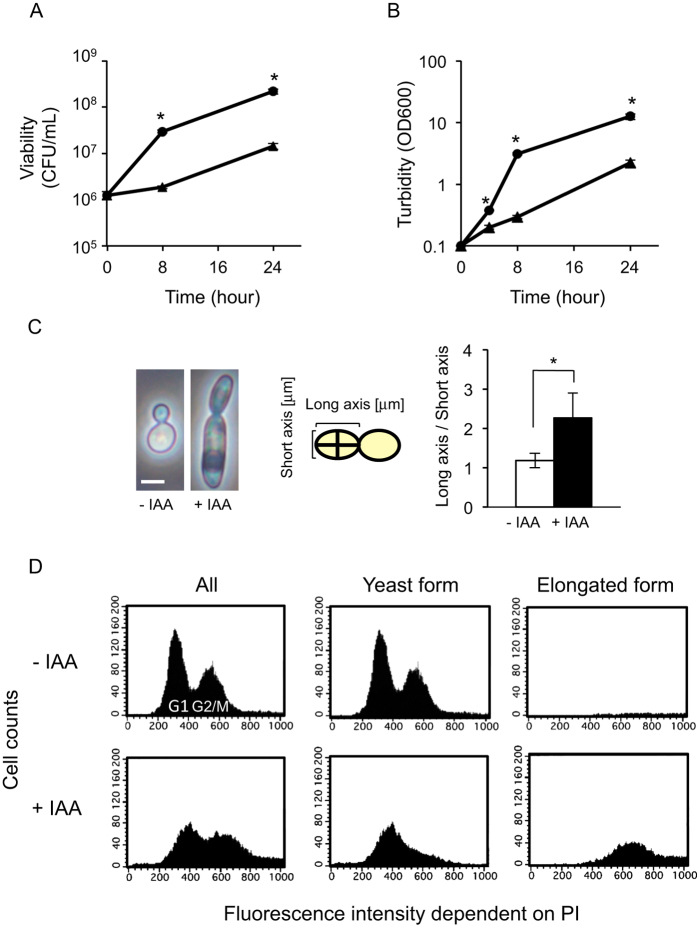
Effects of IAA on viability, proliferation, morphology, and cell cycle.BY4741 cells were incubated in YPD broth with (triangles) or without (circles) 0.5% IAA. (A) Viability was evaluated as colony-forming units/mL. Data are means ± standard deviations of triplicate experiments. *P < 0.05 vs. -IAA. (B) Cell proliferation was evaluated as turbidity of the cell suspension at 600 nm. Data are means ± standard deviations of triplicate experiments. *P < 0.05 vs. -IAA. (C) After 24-h incubation, the length of the long and short axes of cells was measured. Data are means ± standard deviations of triplicate experiments. In each experiment, the cells were selected at random (n > 200). *P < 0.05 vs. -IAA. Bars, 4 μm. (D) After 24-h incubation, the propidium iodide-stained cells stained were subjected to cell cycle analysis using FACS. Cells showing sizes similar to those of untreated cells were regarded the yeast form. Cells larger than untreated cells were regarded the elongated form.